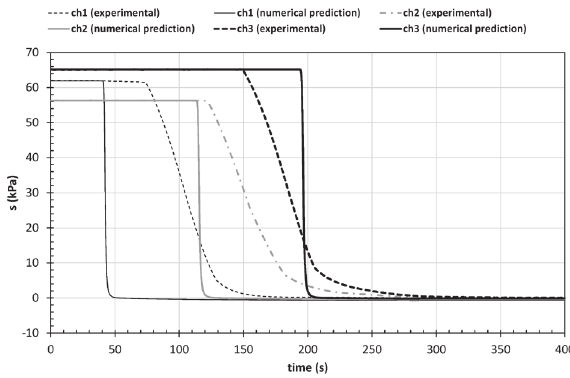
Figure 8: First imbibition phase: experimental data and corresponding numerical results